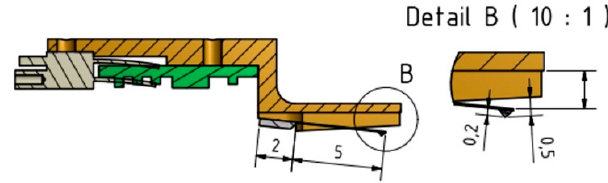
Figure 34. Cross section through the measuring head of a MicroProfiler-B with the inclined cantilever microprobe.